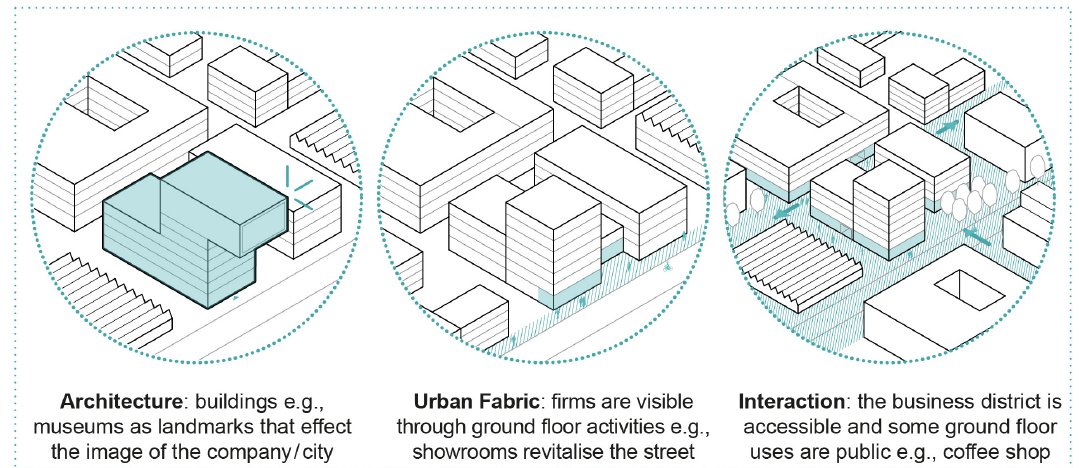
Figure 1. Types of spatial and structural connection (marked in green; see descriptions in Subsections 3.1.1—3.1.3). Urban Planning, 2021, Volume 6, Issue 3, Pages